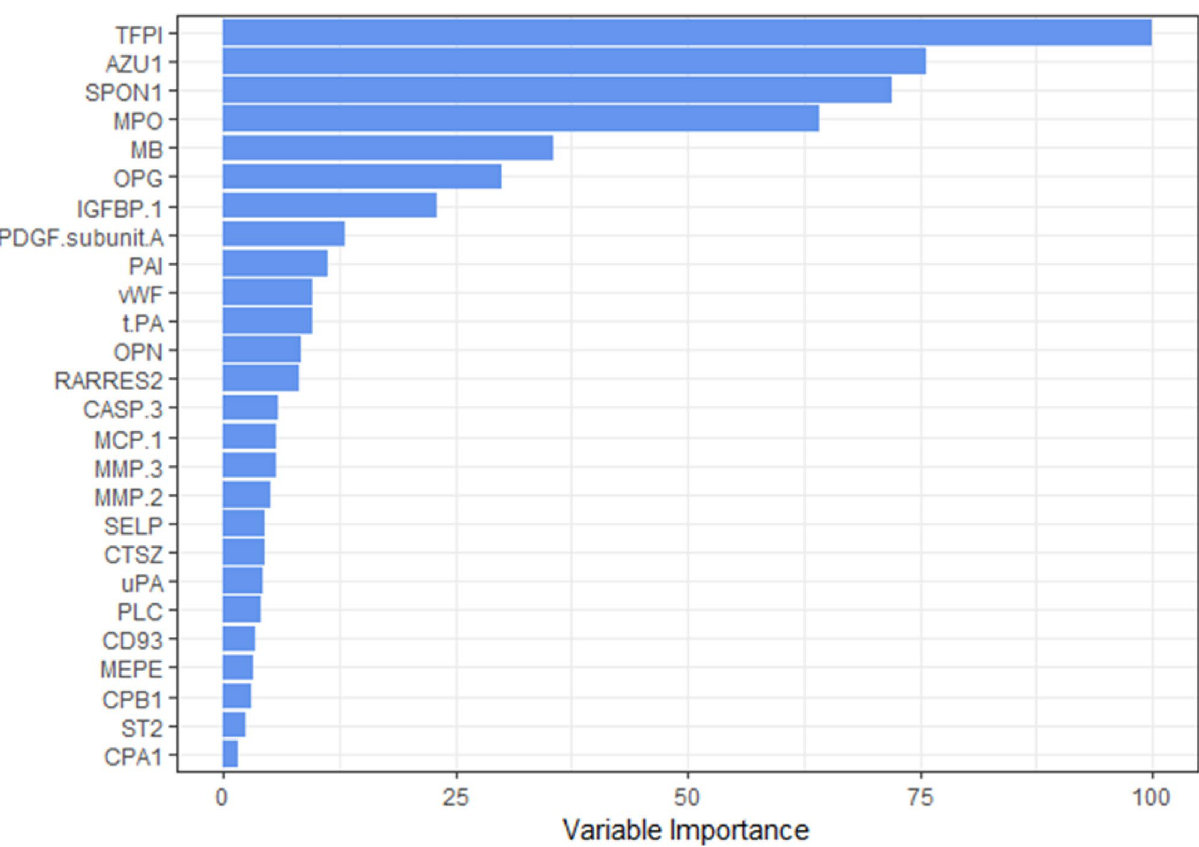
Figure 3. Predictor importance plot for the random forest model trained on the discovery set. Predictor importance is computed using the mean decrease in Gini index, and plotted relative to the protein tissue factor pathway inhibitor (TFPI), which had the maximum mean decrease in Gini index among the 26 proteins. This figure was made with the R software package called ggplot2, version 3.3.2: Wickham; ggplot2: Elegant